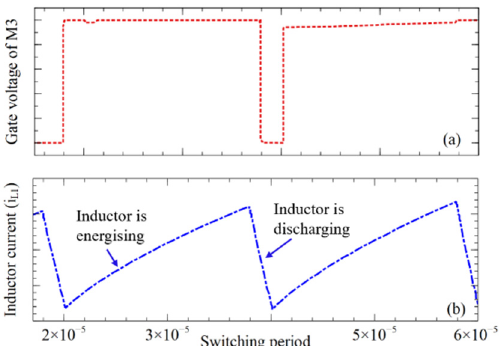
Figure 13. Applied Gate voltage and inductor current over one switching period according to Mode 2 and Mode 3.